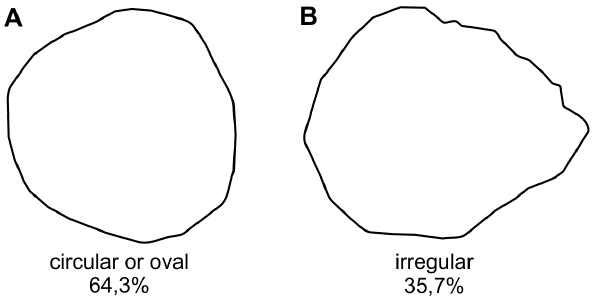
Figure 2. Two morphotypes of the inner outlines of holes and their frequency distribution (drawings by camera lucida).